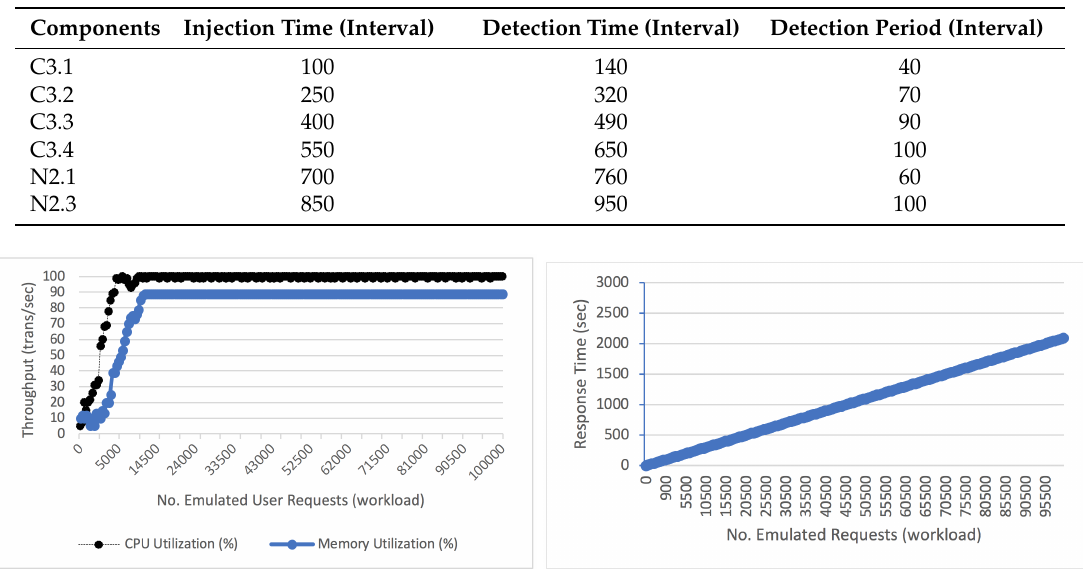
Figure 7. Workload–throughput ( left ) and response time ( right ) over No. of user